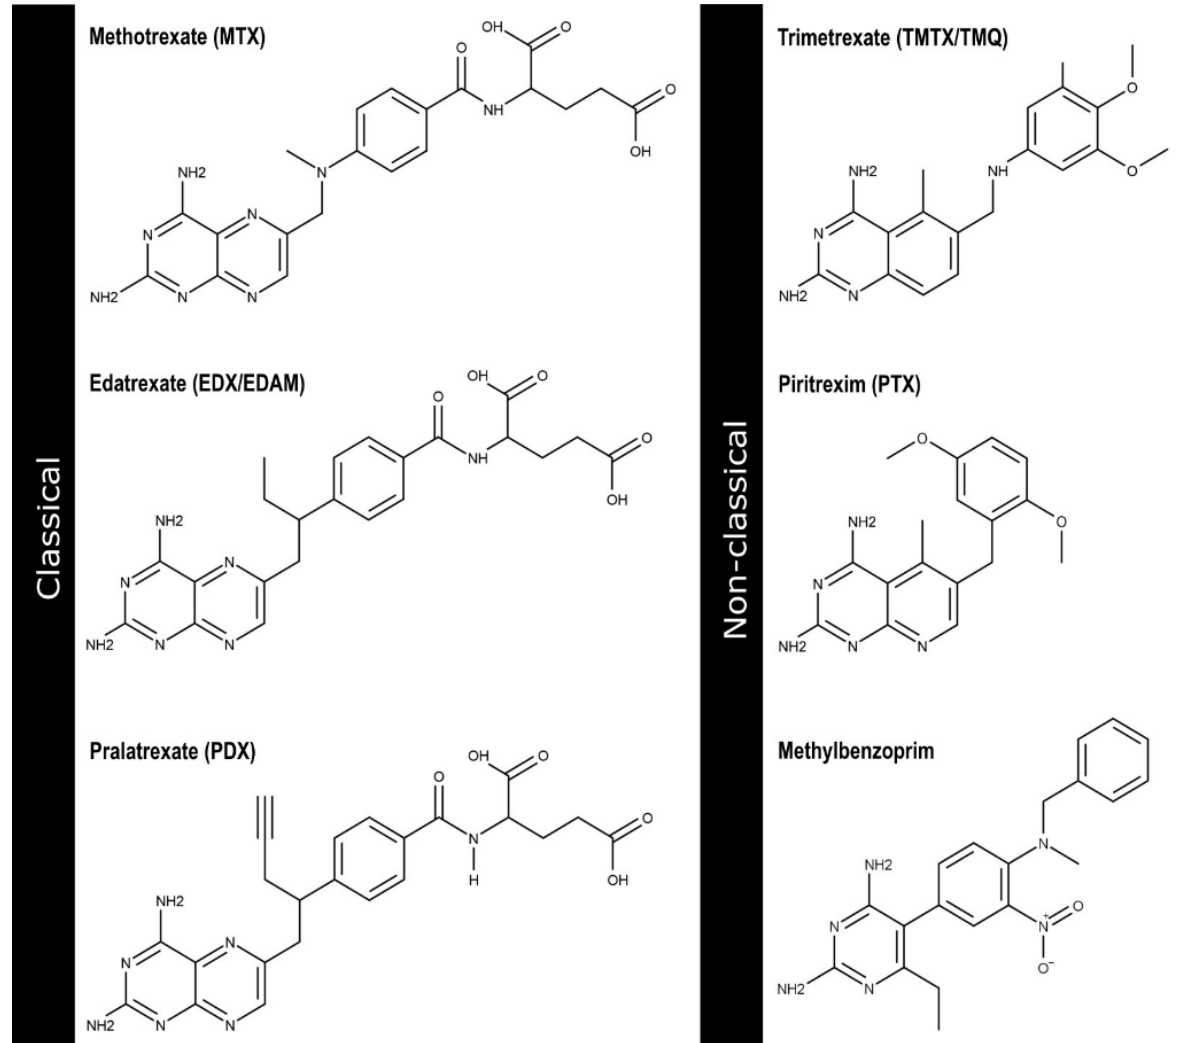
Figure 1. Classical and non-classical human DHFR inhibitors. The 2D chemical structures of methotrexate (ZINC01529323), edatrexate (ZINC01618702), pralatrexate (ZINC01536109), trimetrexate (ZINC00598852), piritrexim (ZINC00000640), and methylbenzoprim (ZINC03777839) were prepared with MarvinSketch v17.14, 2017, ChemAxon.